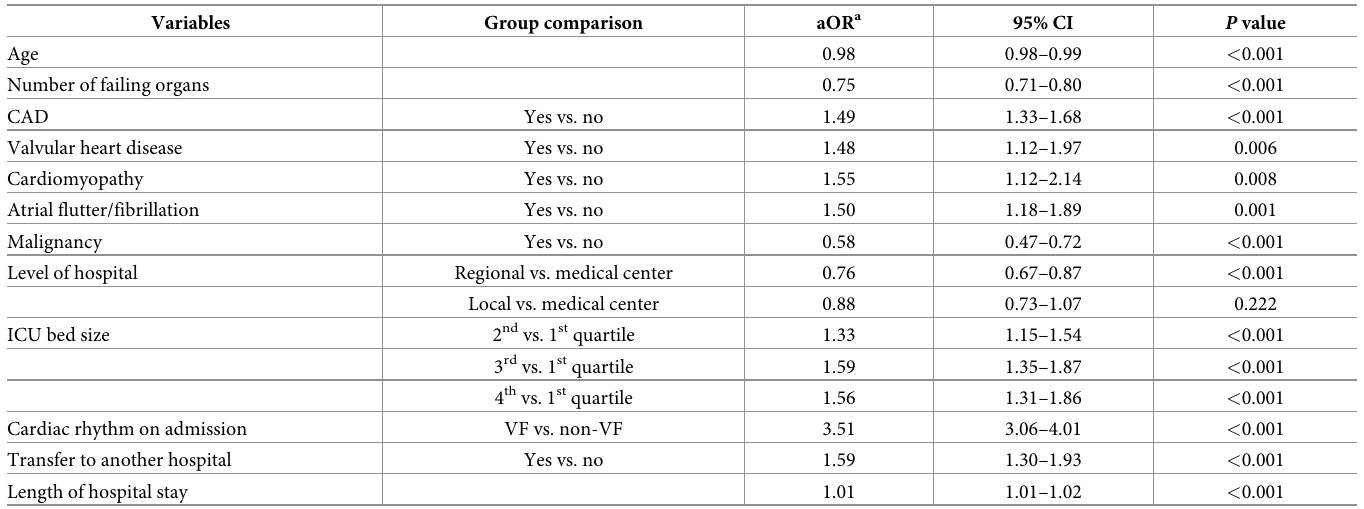
Table 4. Survival factors for hospitalized OHCA patients.